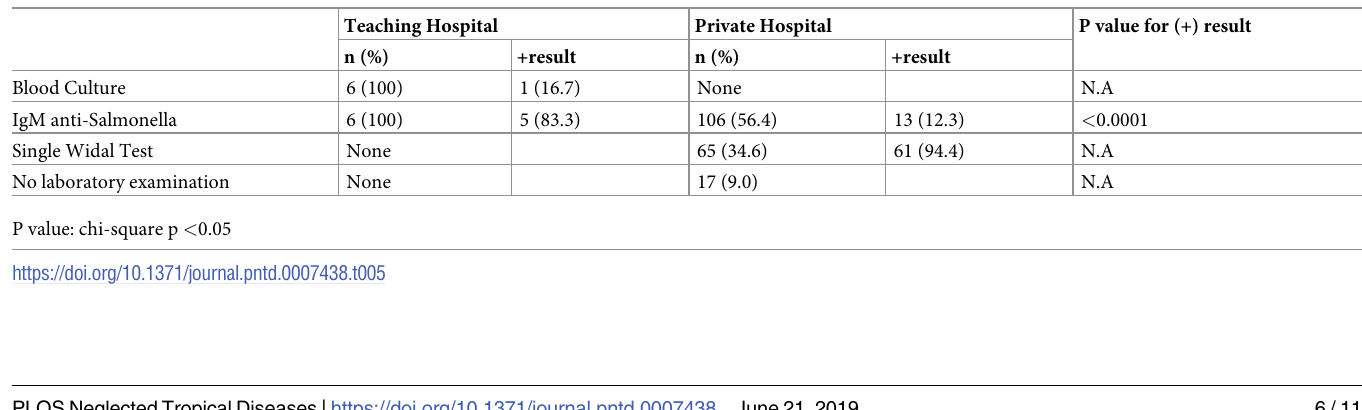
Table 5. Laboratory confirmations among presumed concurrent typhoid